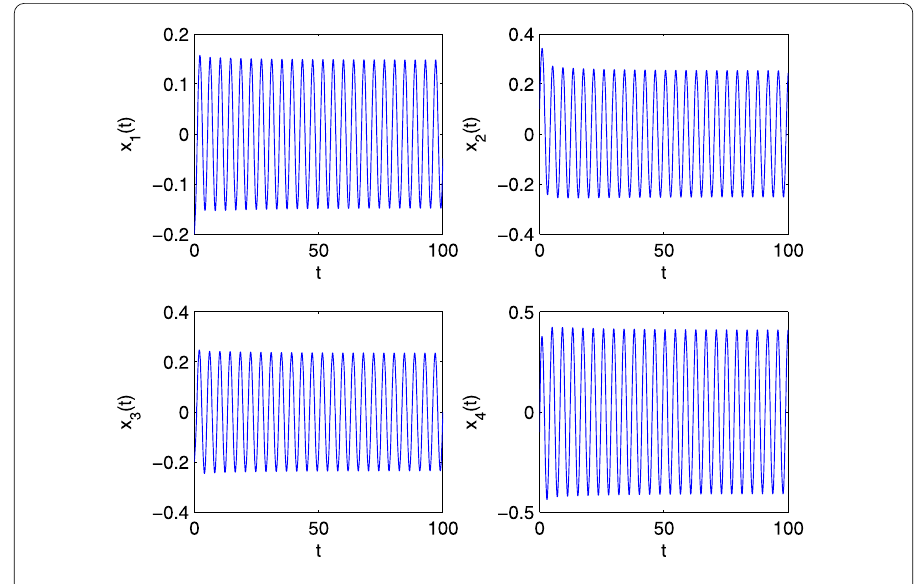
Figure 7 Time responses of system (5.2) with φ = 0.92, τ = 0.42 > τ ∗ 0 = 0.3976